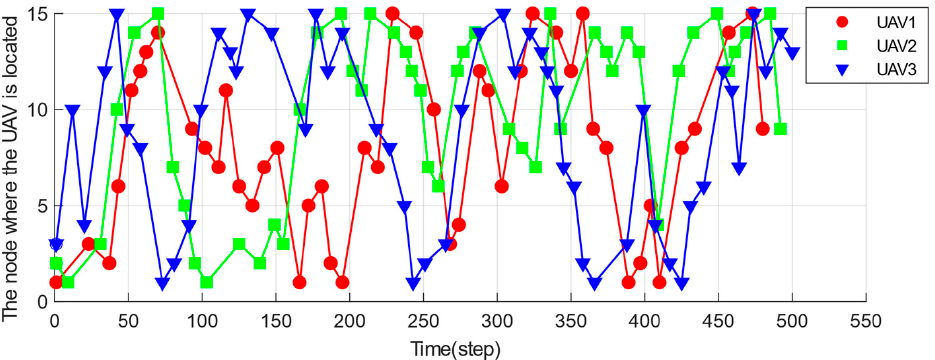
Figure 10. The monitoring path in incomplete environment obtained by OMACO algorithm.